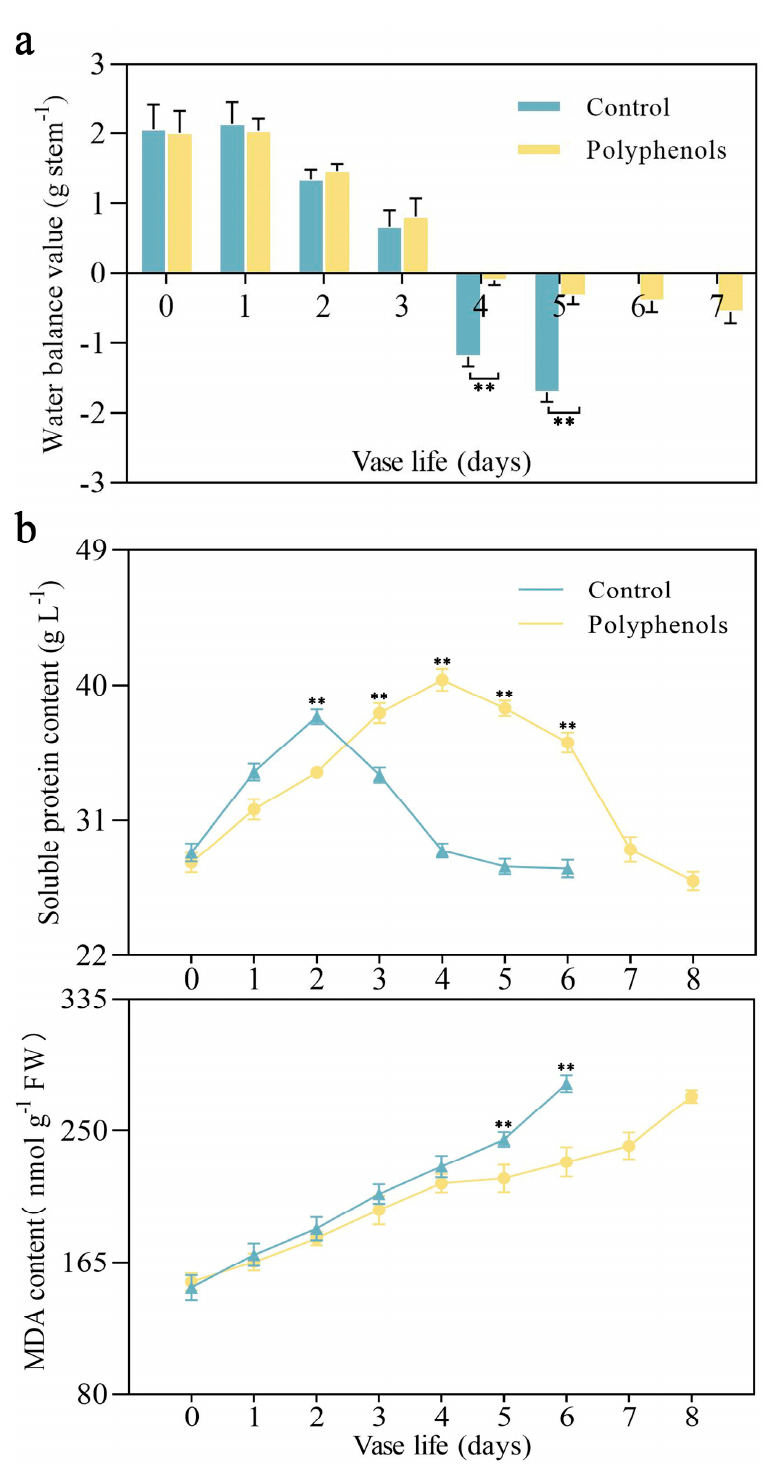
Figure 2. Effect of polyphenols on physiological indexes of cut herbaceous peony flowers. ( a ) Effect of polyphenols on the water balance value of cut herbaceous peony flowers during the vase life. ( b ) Effect of polyphenols on soluble protein and MDA content of cut herbaceous peony flowers during the vase life. ** indicates highly significant difference of data, p <